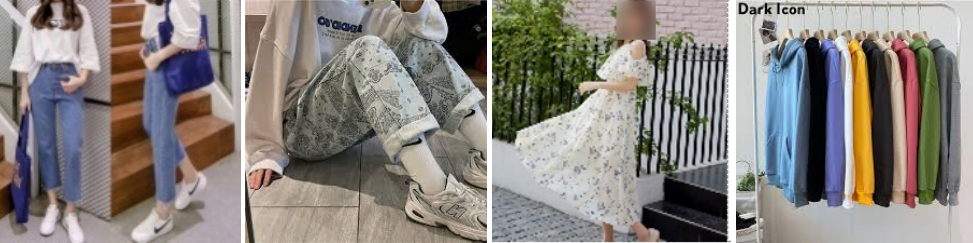
Figure 2. Samples of our Dataset.